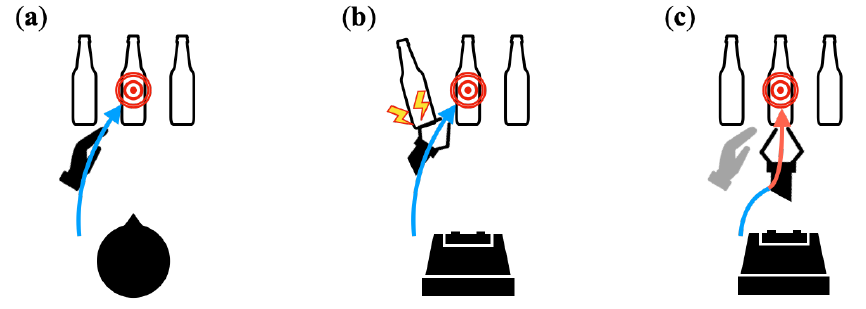
Figure 1. Shared control of grasping assistance to resolve differences in human and robot physical structures: ( a ) Humans plan movements based on information about their own physical structure. ( b ) When robots are manually and remotely operated by humans, differences in the physical structures of humans and robots reduce operability. ( c ) Shared control, which fuses control commands from humans and robots, supports task